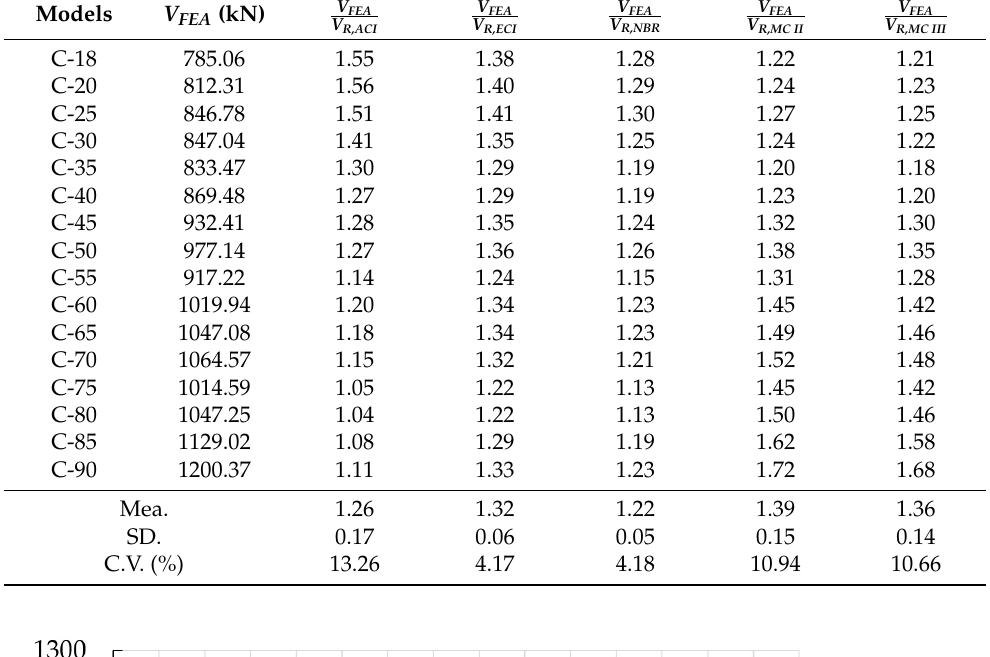
Table 7. Comparison between numerical and theoretical breaking loads (Series C).